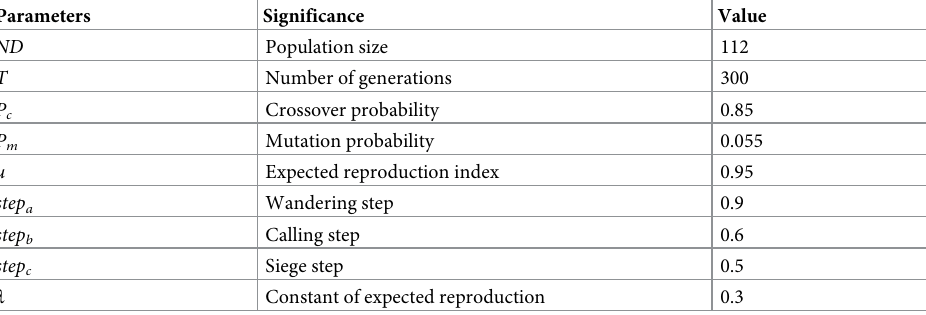
Table 4. Best MOIWCA parameter for 14 activities in the Beijing-Shanghai high speed railway